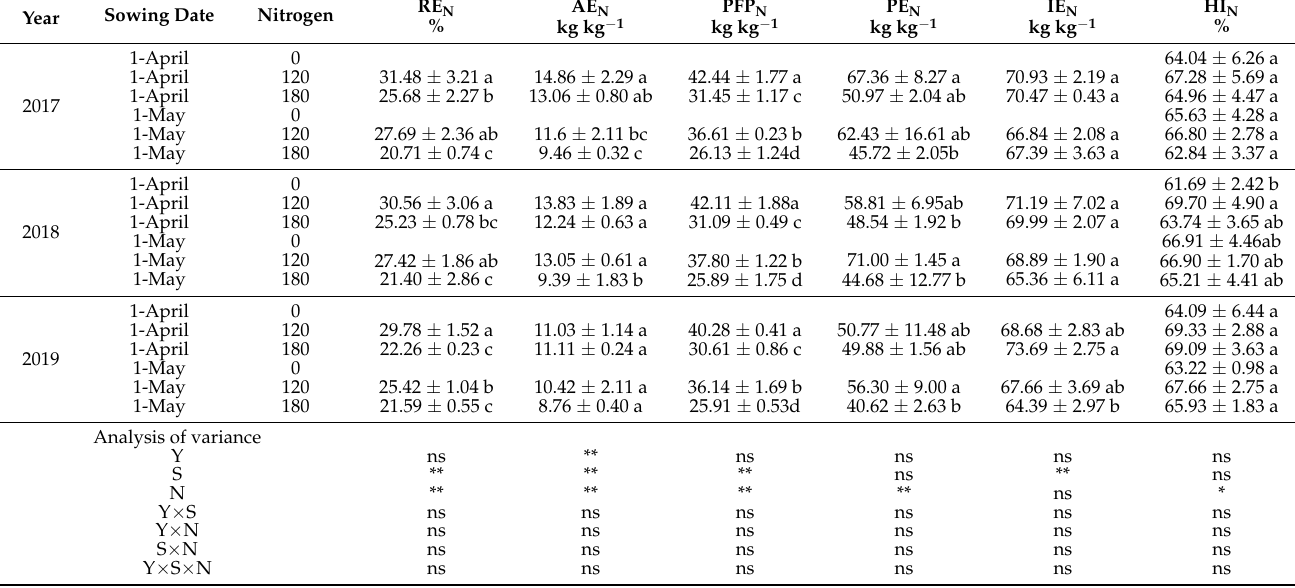
Table 4. Effect of sowing date and nitrogen application on N use